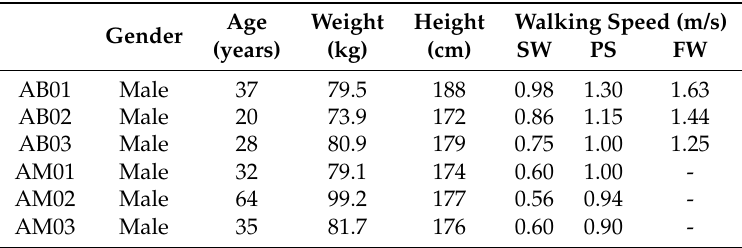
Table 1. Physical characteristics of the six human test subjects. AB and AM represent able-bodied and amputee subject, respectively. Age Weight Gender